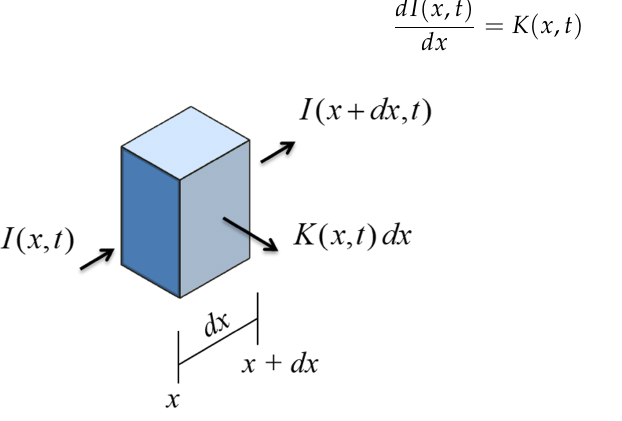
Figure 5. Current balance of an infinitesimal